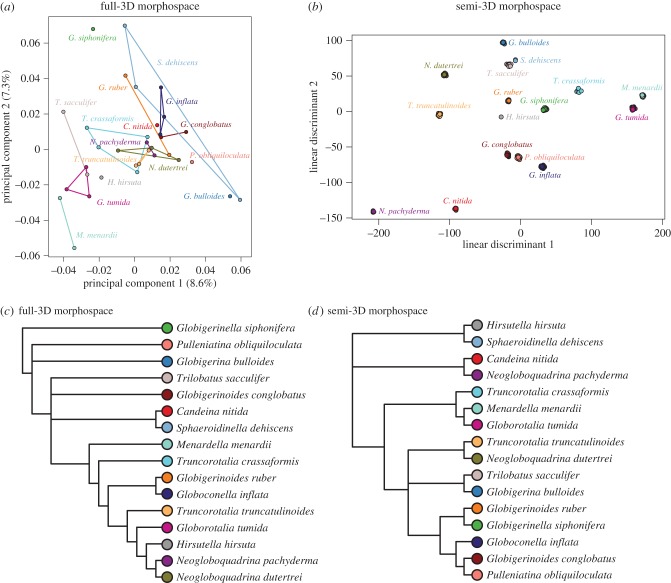
Morphospaces and majority-rule consensus cluster dendrograms for the 16 species that overlap between the Tohoku University dataset (a,c) and our novel coretop/exemplar dataset (b,d) (post-LDA; see text). Coloured lines define convex hulls for each species. Dendrogram tip label colours correspond to morphospace species colours.